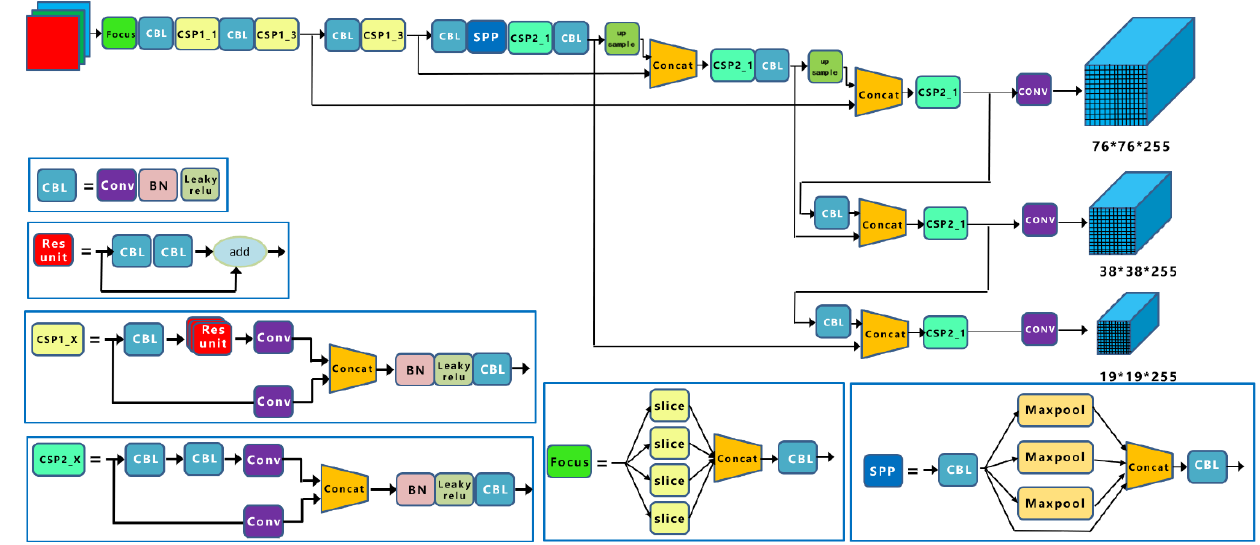
Figure 8. YOLOv5 network structure.